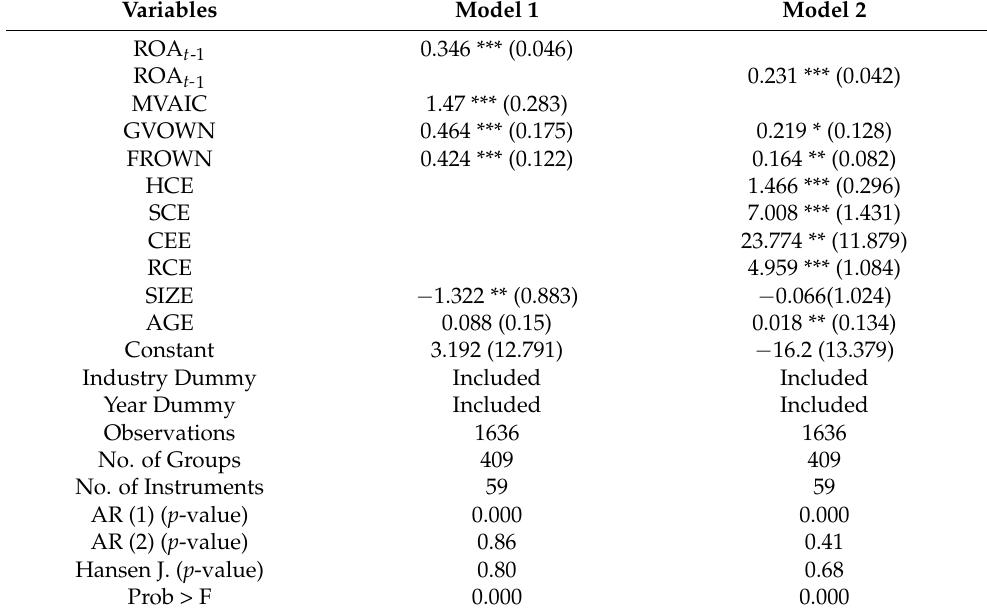
Table 5. Results of GMM